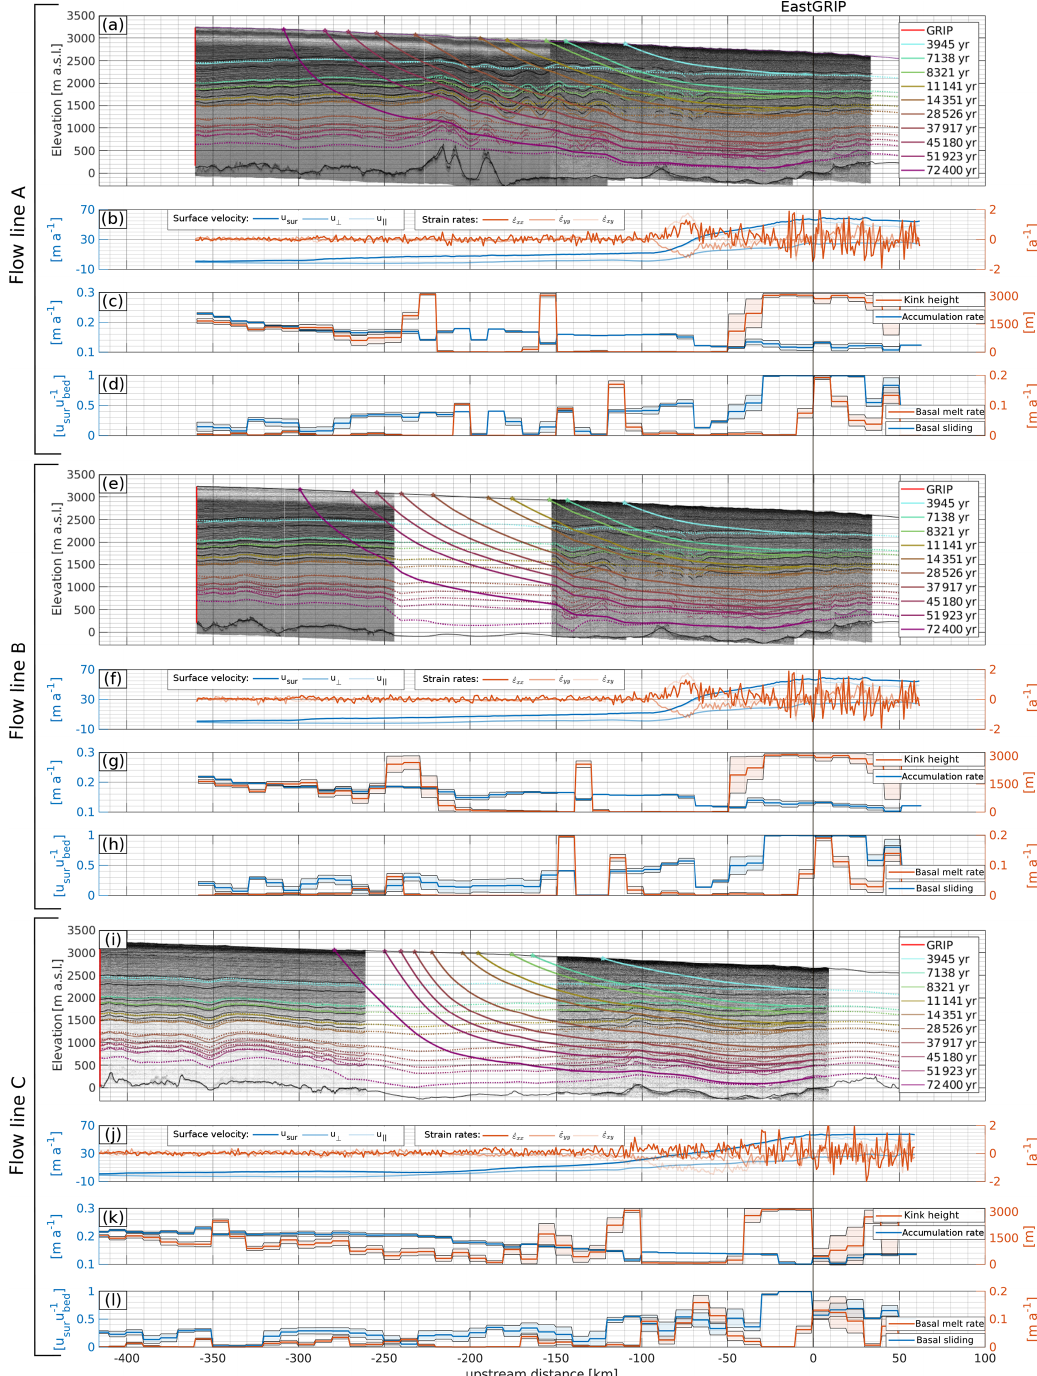
Figure 4. Flow-line characteristics and model parameters for the approximated flow lines A (a–d) , B (e–h) , and C (i–l) . IRHs were traced (thin solid lines) in the RES images and simulated (dashed lines) with a two-dimensional Dansgaard–Johnsen model (a, e, i) . From the modelled velocity field, we calculated particle trajectories (thick solid lines) backwards in time to obtain estimates of the source location for specific depths in the EastGRIP ice core. The colours of the lines indicate the age of the isochrones and the respective time of snow deposition and are identical to the colour code in Figs. 5 and 7. The horizontal strain rates at the surface were calculated from the MEaSUREs Multi-year v1 (Joughin et al., 2018) surface velocities (b, f, j) . The mean and standard deviations of the sampled model parameters accumulation rate, kink height, basal melt rate and basal sliding (c, d, g, h, k, l) were obtained from a Monte Carlo inversion by reducing the misfit between observed and simulated data. All panels are aligned at EastGRIP, and the x axis indicates the distance from the borehole